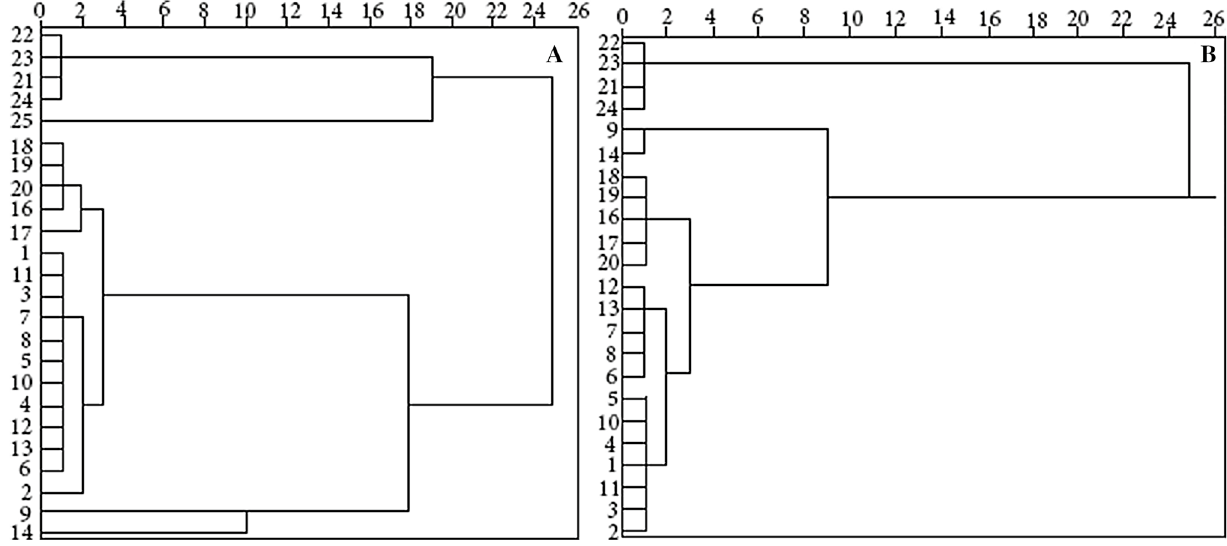
Fig. 6 Dendrogram of sampling stations in the lake and downstream of the Gotvand-e-Olya Dam; a nearest neighbor method and b wards method (the first-time sampling)